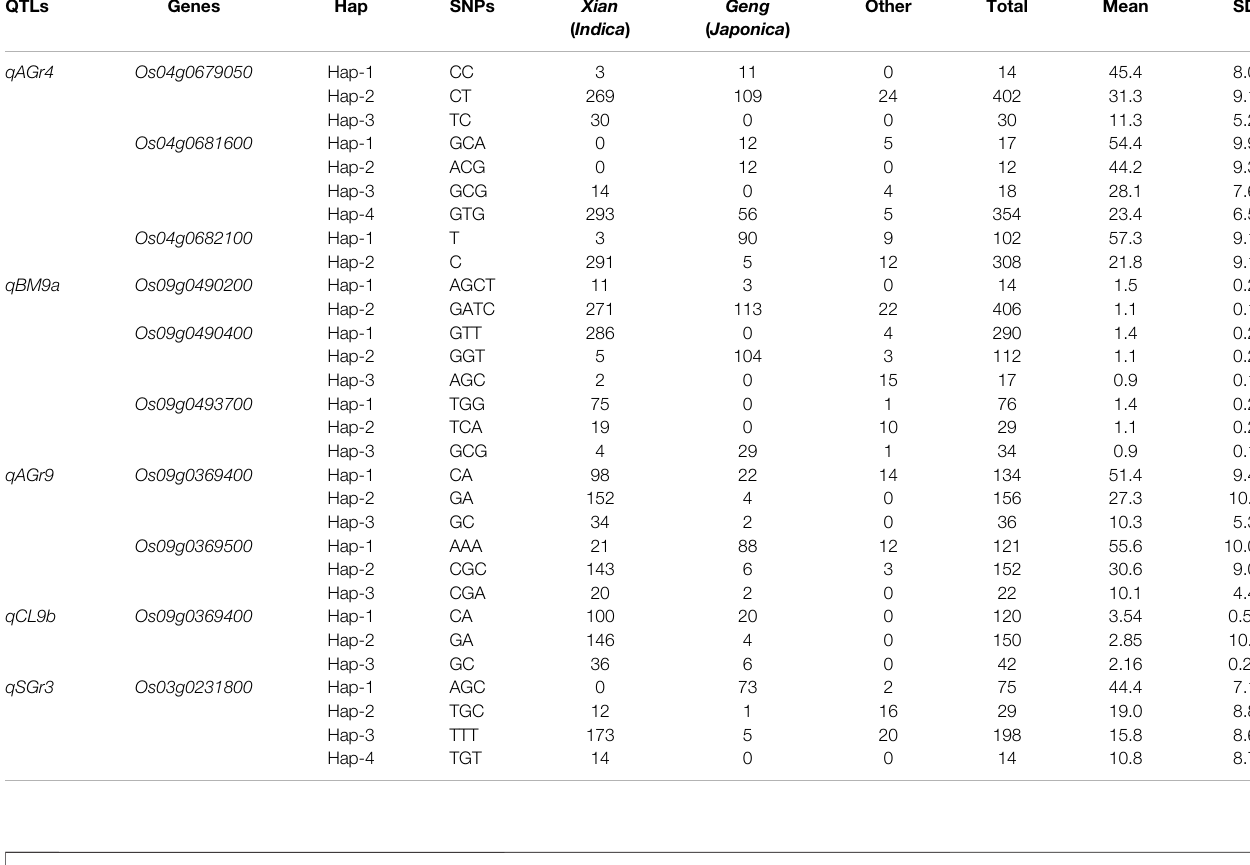
TABLE 3 | Haplotype analysis of the candidate genes for important QTL regions. QTLs